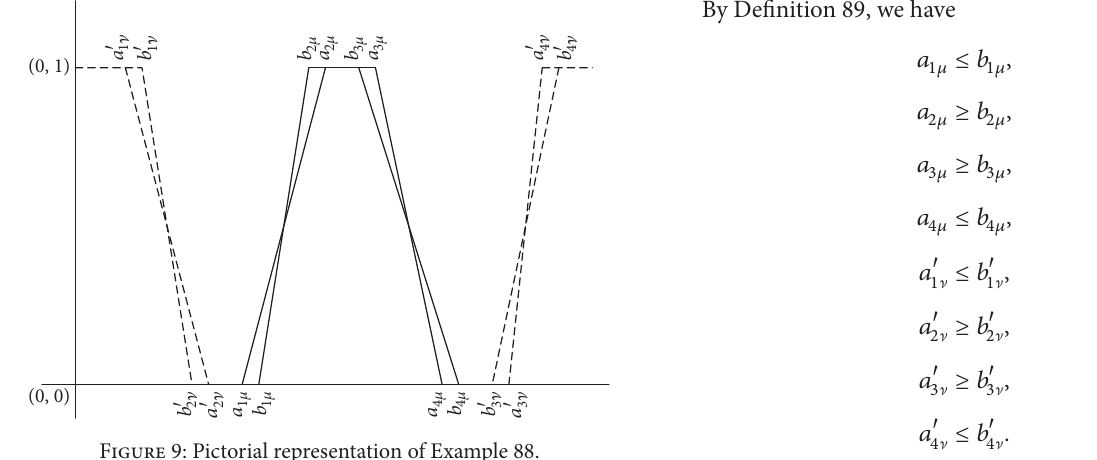
𝑎 󸀠 ≤ 𝑏 󸀠 , 𝑎 󸀠 ≥ 𝑏 󸀠 , 𝑎 󸀠 ≥ 𝑏 󸀠 , 𝑎 󸀠 ≤ 𝑏 󸀠 𝐴 ≫ 𝐵 𝐼 𝐼 then one 1 ] 1 ] 2 ] 2 ] 3 ] 3 ] 4 ] 4 ] . If of the above inequalities becomes strict